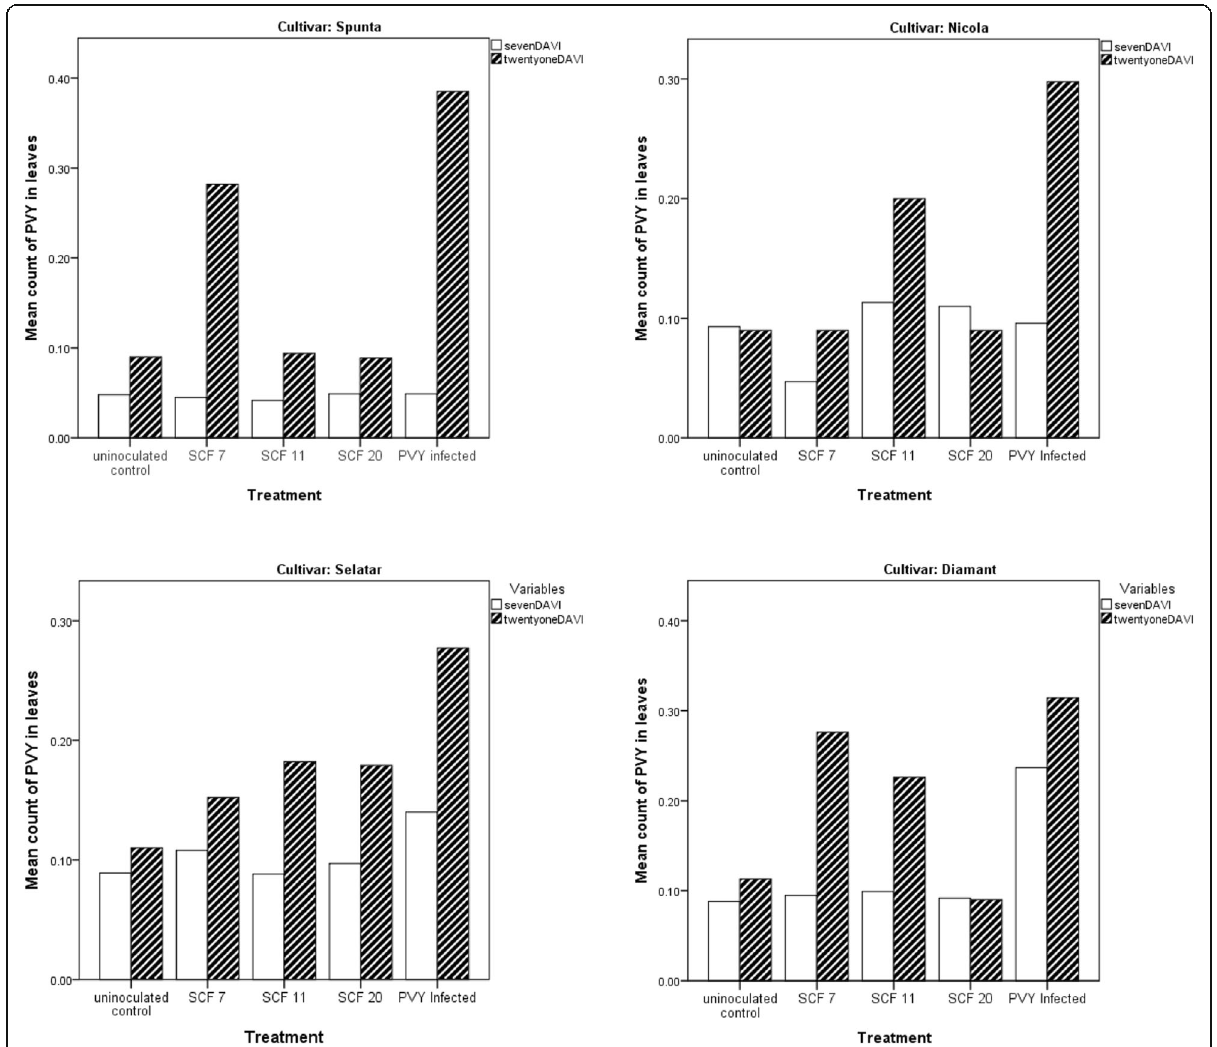
Fig. 2 The effect of different SCF on PVY NTN concentrations in leaves of four potato cultivars using DAS- ELISA treated with SCF (SCF7, SCF11, and SCF20) at 7 and 21 days after virus inoculation (DAVI). SCF7 = Streptomyces netropsis DSM 40093, SCF11 = Streptomyces ambofaciens , and SCF20 = Streptomyces actuosus . Columns represent mean of OD values at 405 nm of PVY NTN level using